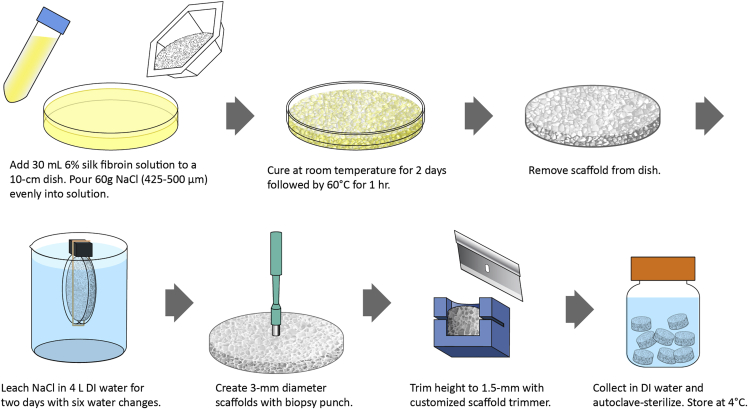
Preparation of silk scaffoldsSee also Methods Videos S6, S7, S8, and S9.